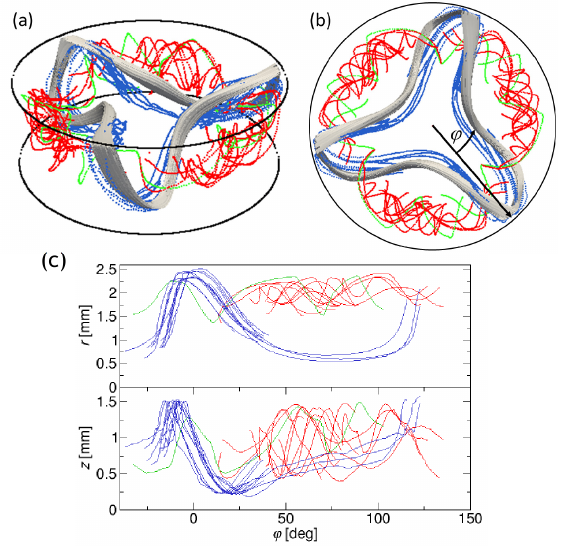
Figure 9. Reconstructed trajectories of particles in ( a ) bird’s-eye view and ( b ) top view, respectively, in the liquid bridge of Pr = 28.6, Γ = 0.68 ( R = 2.5mm), and V / V 0 = 1.0 with suspended particles of 30µm in diameter. The figures consist of the trajectories of the particles on the PAS (14 trajectories in blue), on the core (16 in red) and on the structure wrapping the core (3 in green). The direction of HTW is clockwise, and the net direction of the particles on the PAS is counter-clockwise (in positive φ direction) in the laboratory frame. Bundles of pathlines which form the PAS obtained by the numerical simulation [67] are also drawn in grey. Frame ( c ): distributions of all trajectories in the r - φ (top) and the z - φ (bottom) planes. (Figure 9 in Oba et al. [14]).